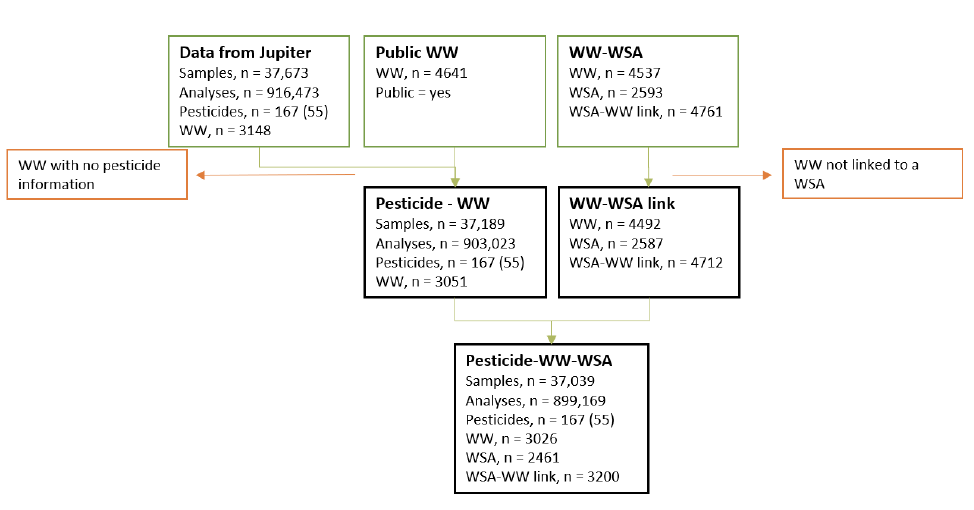
Figure 1. Flow chart illustrating the different data sources and exclusion criteria. Water samples and laboratory analyses are presented by number of observations. Pesticides are represented by the number of pesticides in the dataset, with the number of pesticides above LOD in brackets. Abbreviations: WW: waterworks; WSA: water supply area; LOD: limit of